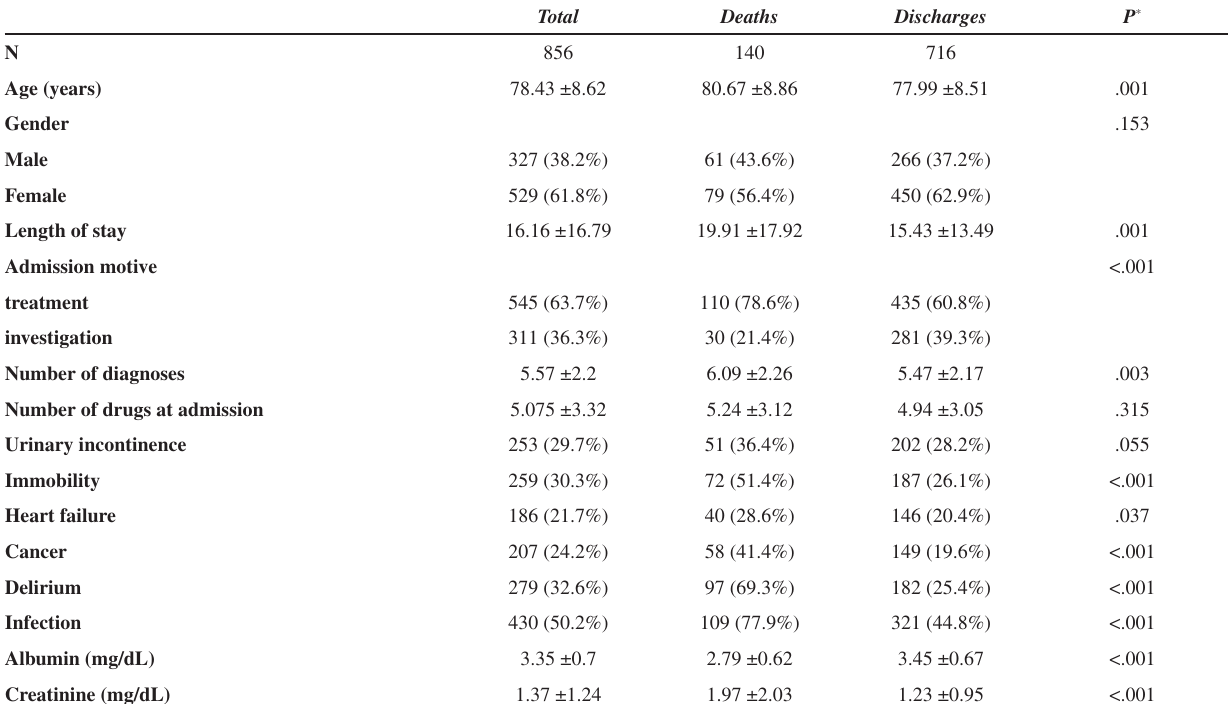
Table 1- Comparison between the demographic, clinical and laboratory characteristics of patients who died and those who were discharged